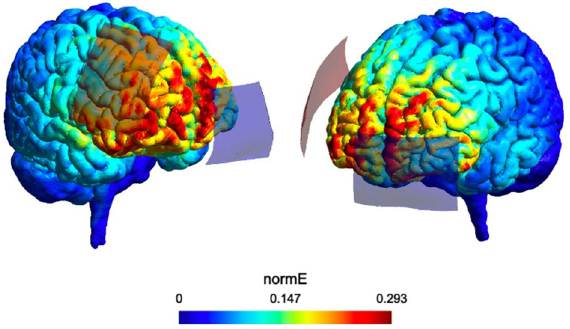
Figure 2. Computational model (SimNIBS software) of electrical current dispersion in cortical surface based on the tDCS montage adopted in the study. normE—Electrical field norm in volt per meter